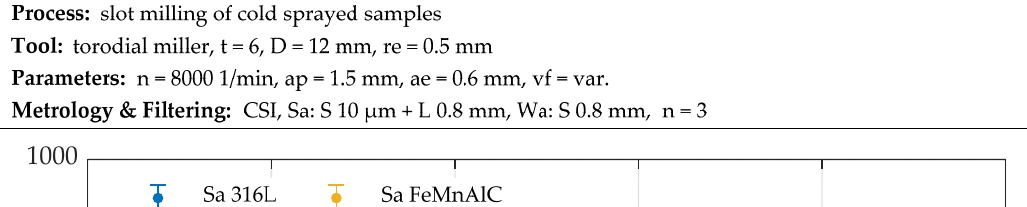
Figure 6. Surface mean heights Sa and Wa versus feed velocity. Error bars indicate standard deviation for repeated meas- urements on the same part.